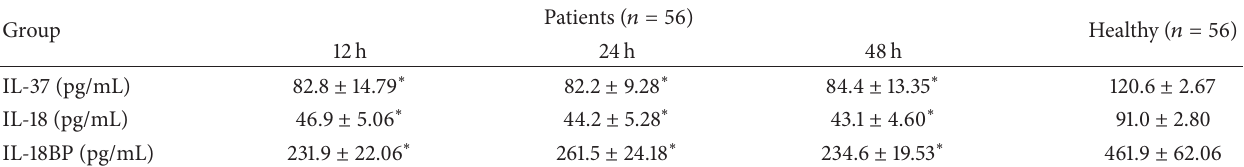
Table 2: Plasma IL-37, IL-18, and IL-18BP expression decreased in 48h after PCI procedure. Patients ( 𝑛 = 56 Group